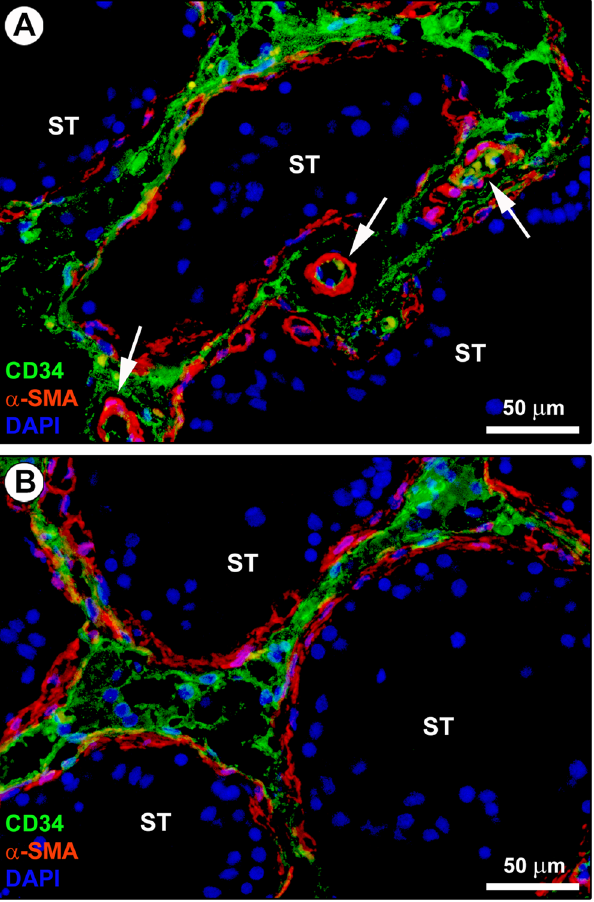
Figure 3. Double immunostaining of human testis sections. ( A,B ) Representative photomicrographs of immunofluorescence labeling for CD34 (green) and α -smooth muscle actin ( α -SMA; red). Nuclei are counterstained in blue with 4 ′ ,6-diamidino-2-phenylindole (DAPI). CD34-negative/ α -SMA-positive myoid cells/myofibroblasts are located in the inner layer of the connective tissue surrounding the seminiferous tubules (ST). Instead, CD34-positive/ α -SMA-negative interstitial cells are located in the outer layer of the peritubular tissue. These two cell types form distinct but closely adjacent networks in the peritubular connective tissue; sporadic yellow staining is visible due to apposition of their cellular prolongations. The CD34-positive/ α - SMA-negative interstitial cells form a continuous network extending from the outer peritubular tissue to the intertubular stroma. CD34-negative/ α -SMA-positive myoid cells/myofibroblasts are absent from the intertubular stroma. α -SMA immunoreactivity is also detected in mural cells (pericytes and smooth muscle cells) of blood vessels (arrows). Scale bar: 50 µ m ( A,B